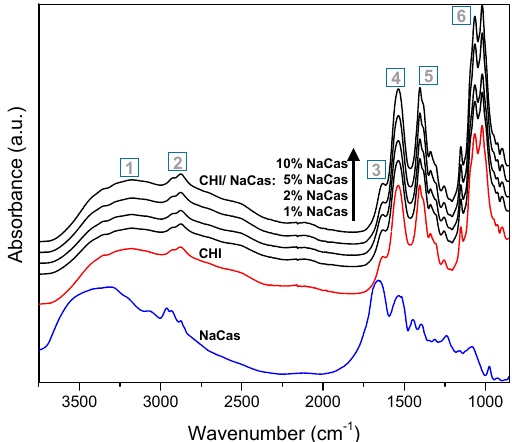
Figure 2. FTIR spectra of oven-dried HMW CHI chitosan/caseinate films prepared by varying the concentration of sodium caseinate (NaCas): 1%; 2%; 5% and 10% (w/w). The assignment of the bands regions 1, 2, 3, 4, 5, and 6 are discussed in detail above in the text in Section 2.2.1.